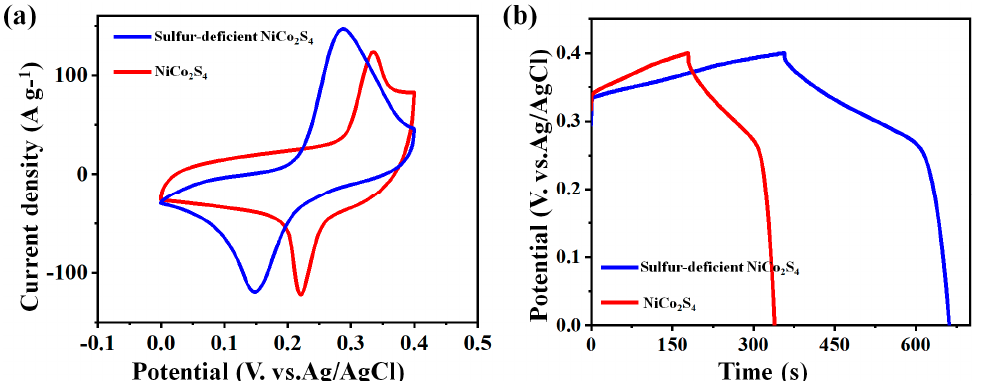
Figure 5. ( a ) CV curves and ( b ) GCD curves of pure NiCo 2 S 4 nanoparticles electrode and sulfur-deficient NiCo 2 S 4 nanosheet composites.